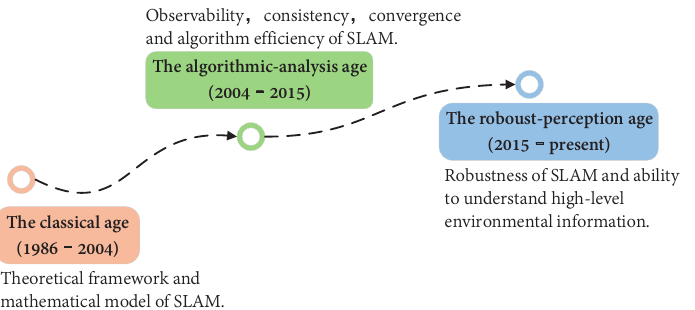
Figure 1. Overview of SLAM development era. The development of SLAM has gone through three main stages: theoretical framework, algorithm analysis, and advanced robust perception. The time points are not strictly limited, but rather represent the development of SLAM at a certain stage and the hot issues that people are interested